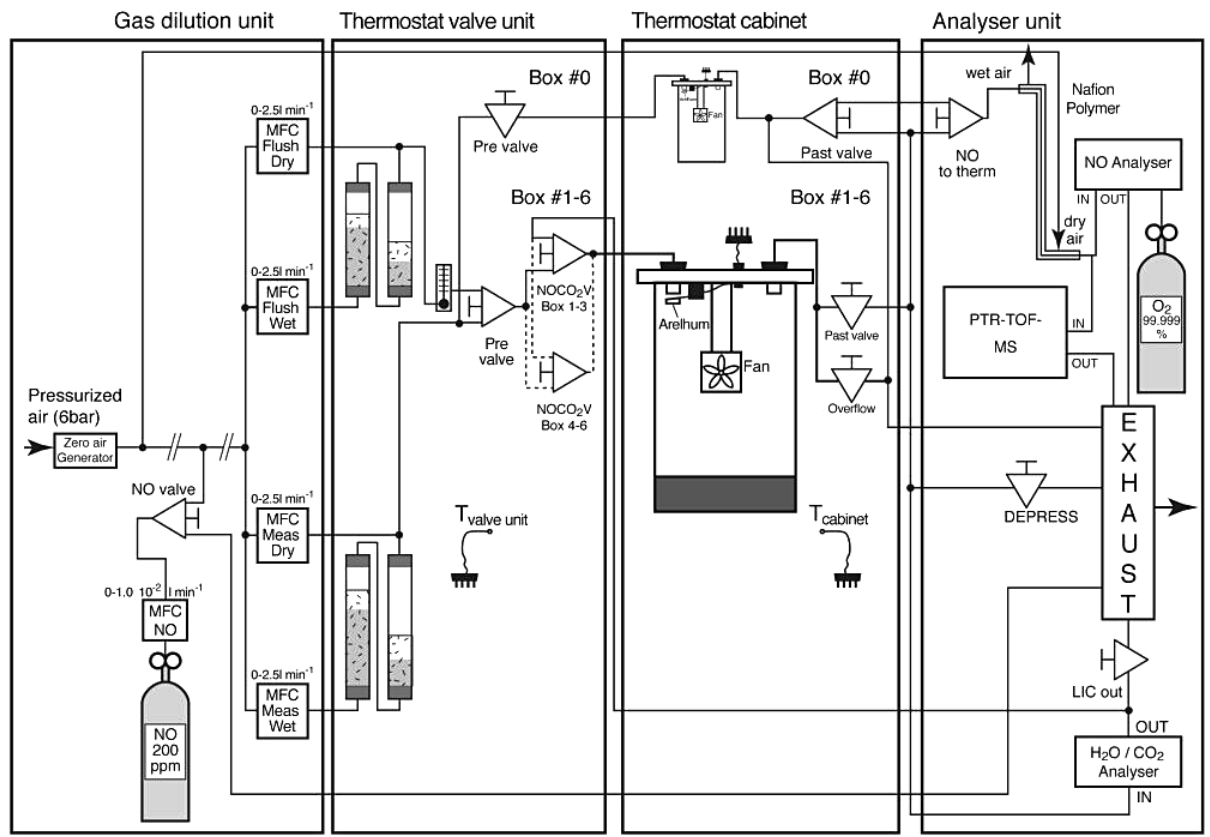
Figure 7. Schematic of the improved laboratory dynamic chamber system, consisting of four units: “gas dilution”, “thermostat valve”, “thermostat cabinet”, and “analysers”. For simplification only two soil chambers are shown in the figure: one reference cell and one soil sample, although there are six soil chambers in